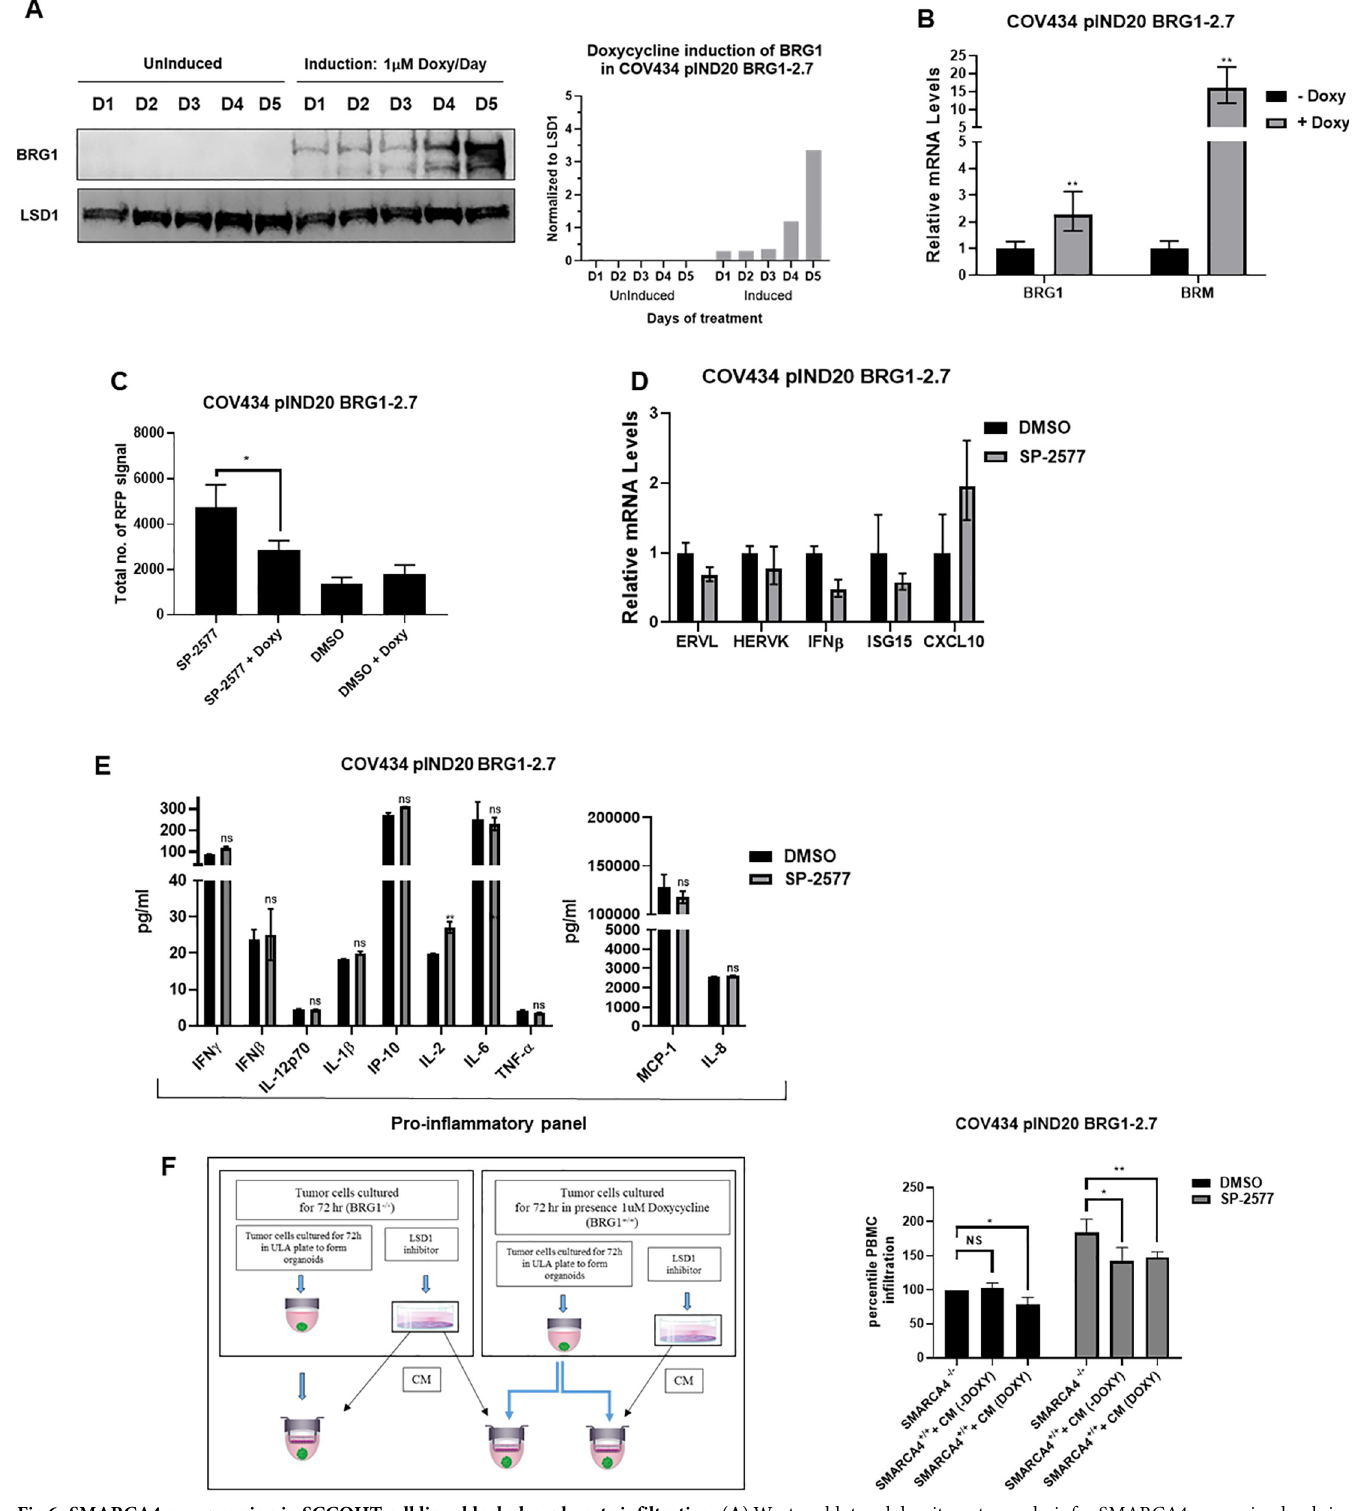
Fig 6. SMARCA4 re-expression in SCCOHT cell lines blocks lymphocyte infiltration. ( A ) Western blot and densitometry analysis for SMARCA4 expression levels in COV 434 pIND20 BRG1-2.7 after 1 μ M doxycycline daily treatment (D = days). Total protein load was verified by LSD1 expression analysis. ( B ) RT-PCR for BRG1 and BRM expression levels in COV434 pIND20 BRG1-2.7. Both gene expression increased after SP-2577 treatment. ( C ) The levels of lymphocyte infiltration are significantly